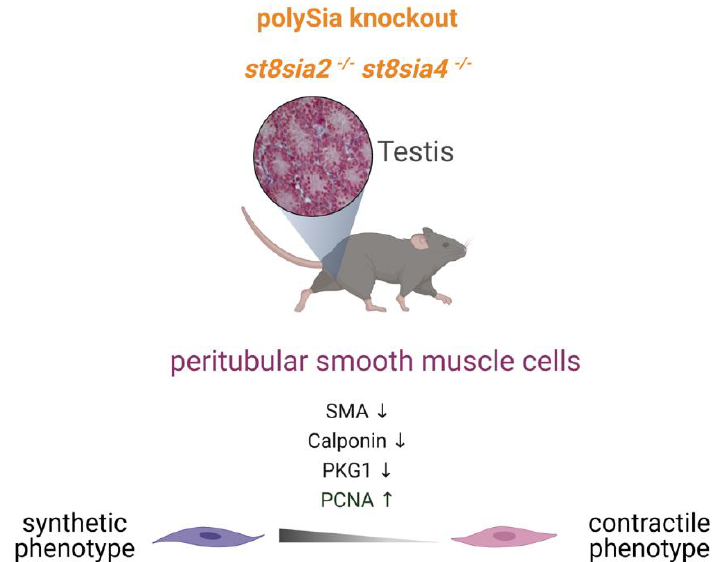
Figure 8. Summary of the observed phenotype. The loss of polySia leads to decreased protein levels of SMA, calponin and PKG1 in addition to increasing cell number of proliferating SMCs (PCNA positive) driving the differentiation of SMCs to a synthetic phenotype. Created with